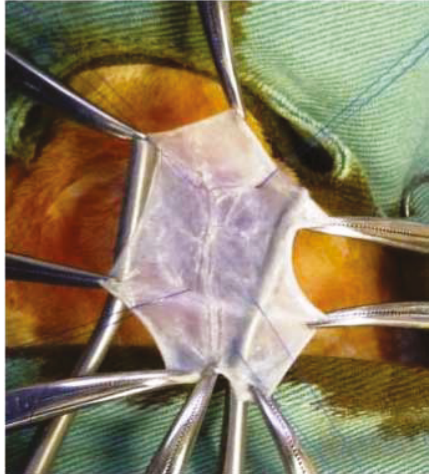
Figure 3: SIS group: implantation of the graft into the tracheal defect.